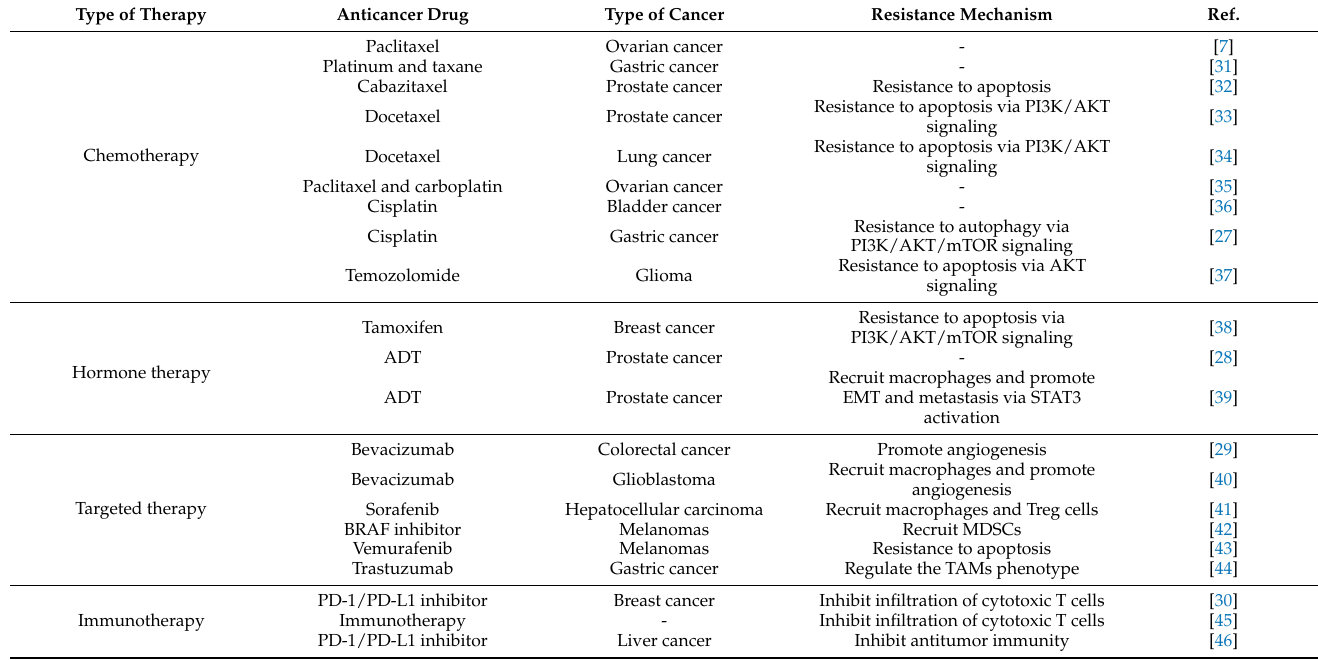
Figure 1. The signaling pathways and multiple biological processes of CCL2. Multiple factors such as hypoxia, proinflammatory cytokines, drugs, and radiation therapy increase the production of CCL2. After binding to CCR2, various intracellular G protein-mediated downstream signaling pathways are activated, such as JAK/STAT, PI3K/AKT, and MAPK pathways, which are related to chemotaxis, survival, proliferation, migration, and anti-apoptosis. Table 1. CCL2 is associated with anticancer drug